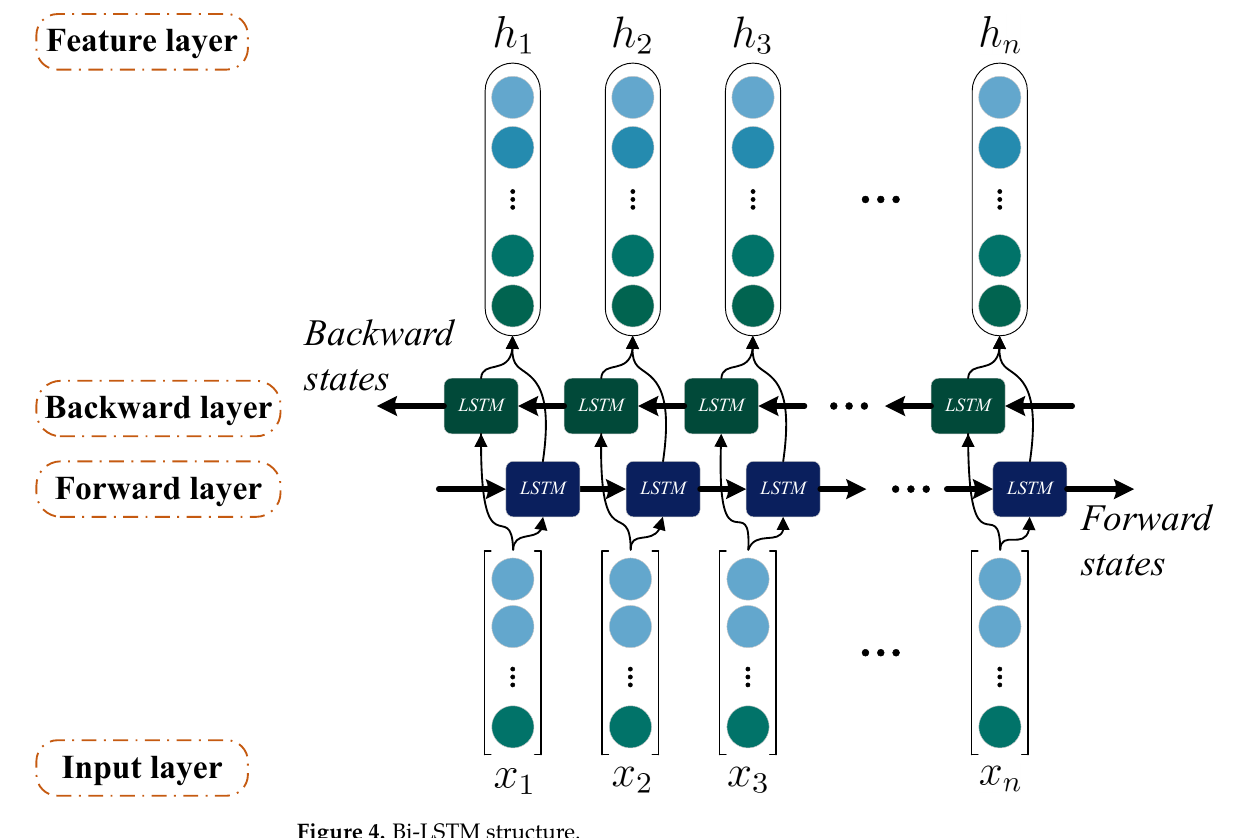
Figure 4. Bi-LSTM